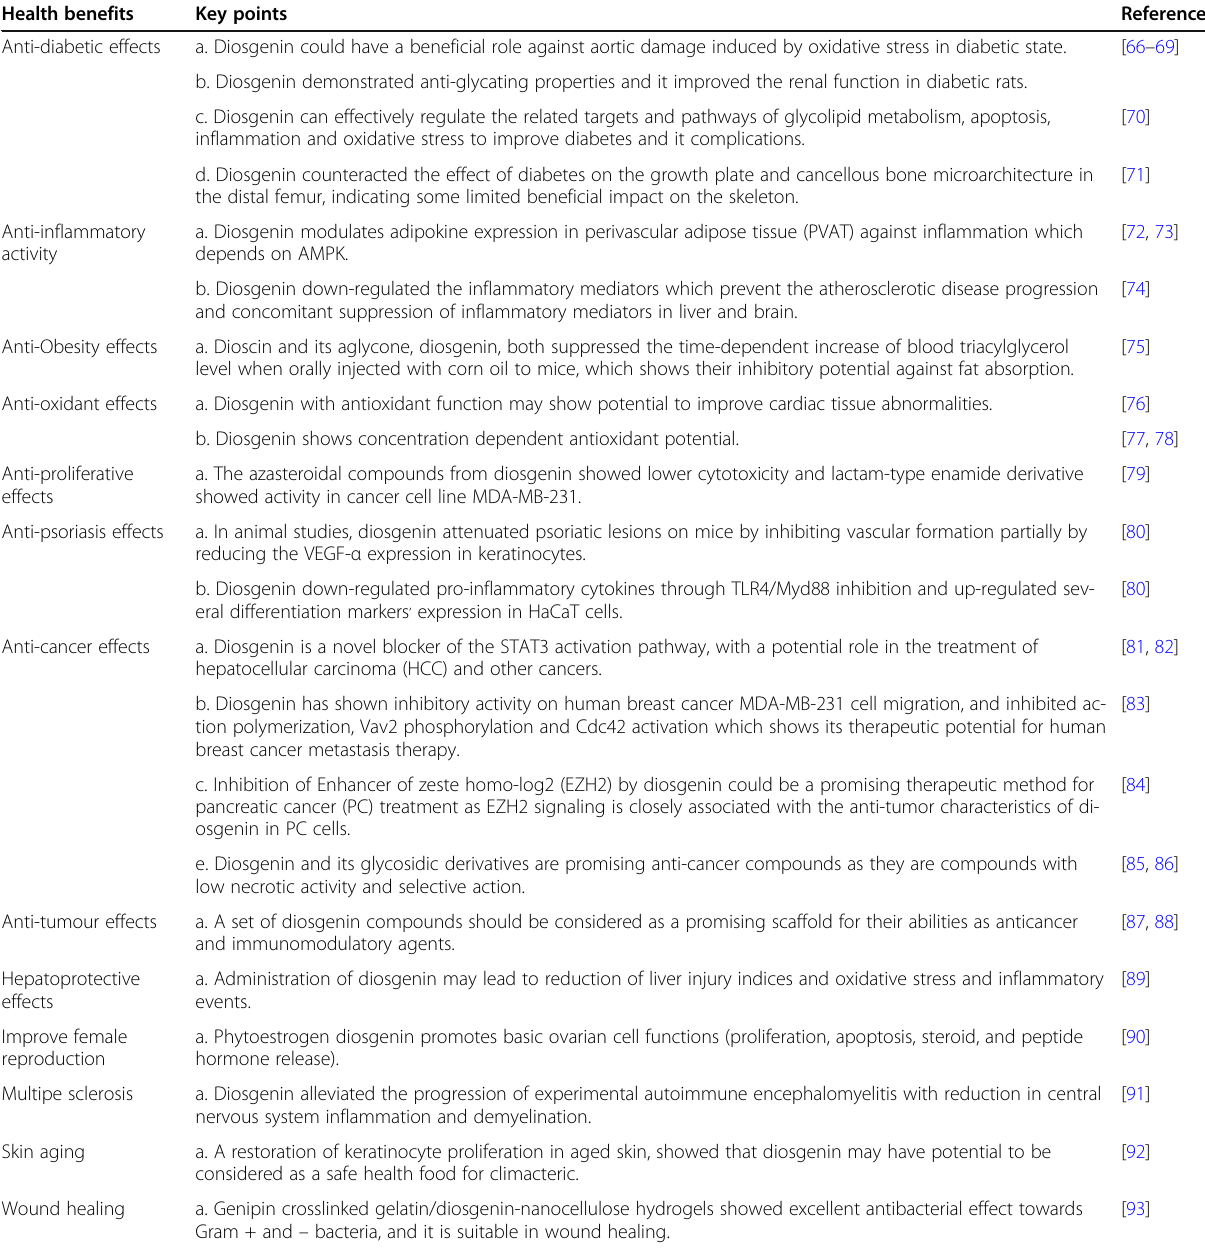
Table 2 The most important pharmacological effects of